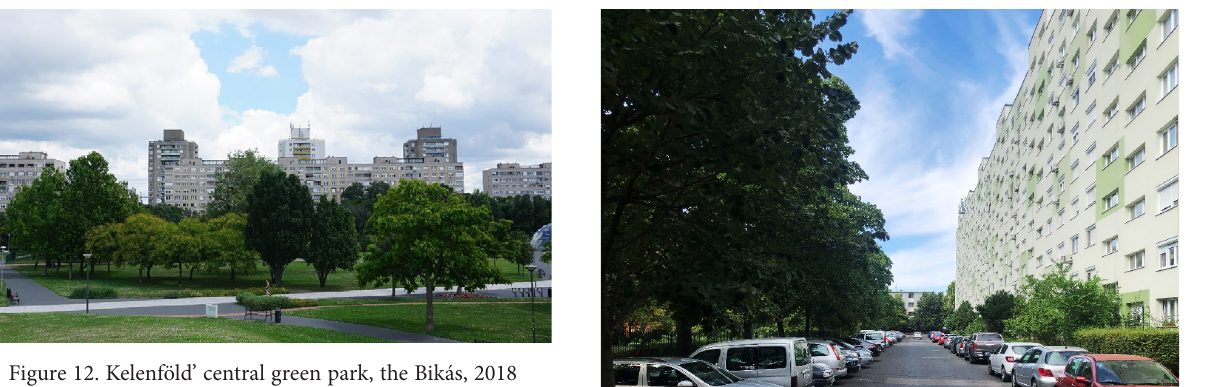
Figure 12. Kelenföld’ central green park, the Bikás, 2018